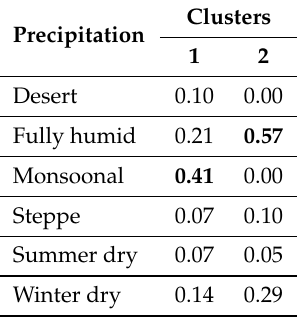
Table 12. Distribution of the categorical variable